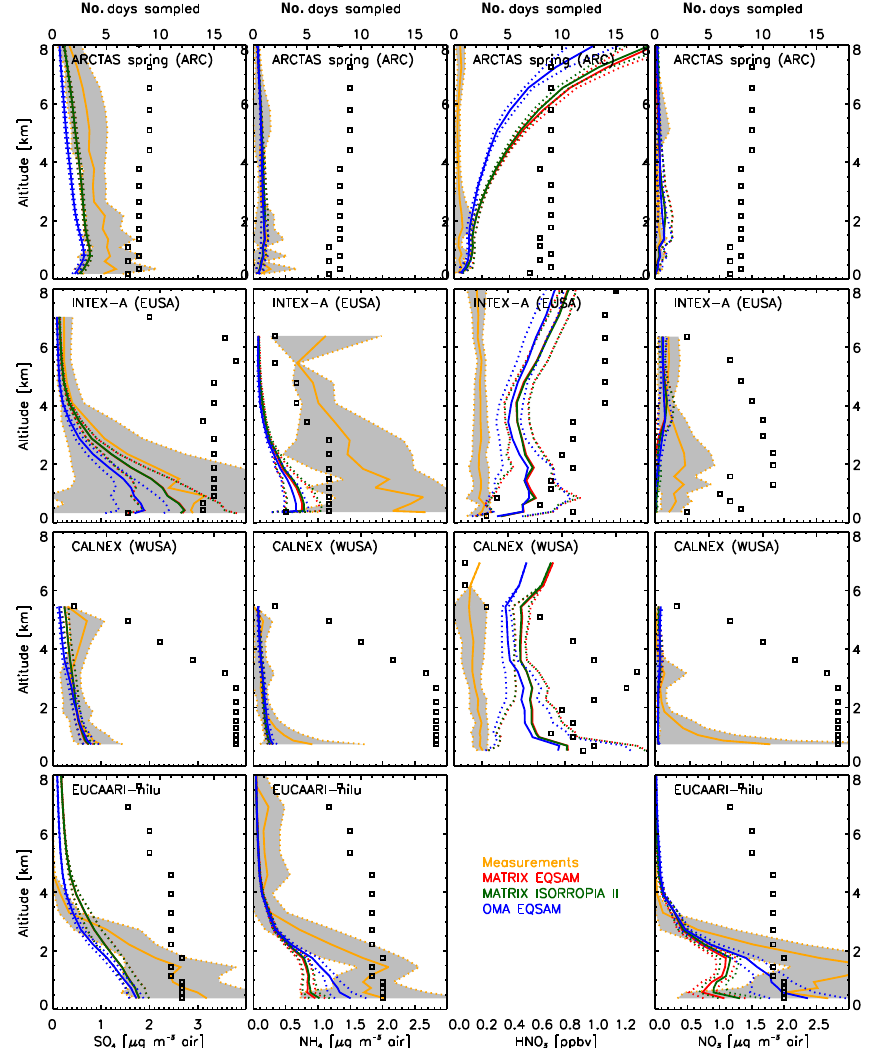
Figure 7. Mean regional concentration profiles from the Arctic (first row), eastern USA (second row), western USA (third row), and Europe (fourth row). First column is SO 4 , second is NH 4 , third is HNO 3 , and fourth is NO 3